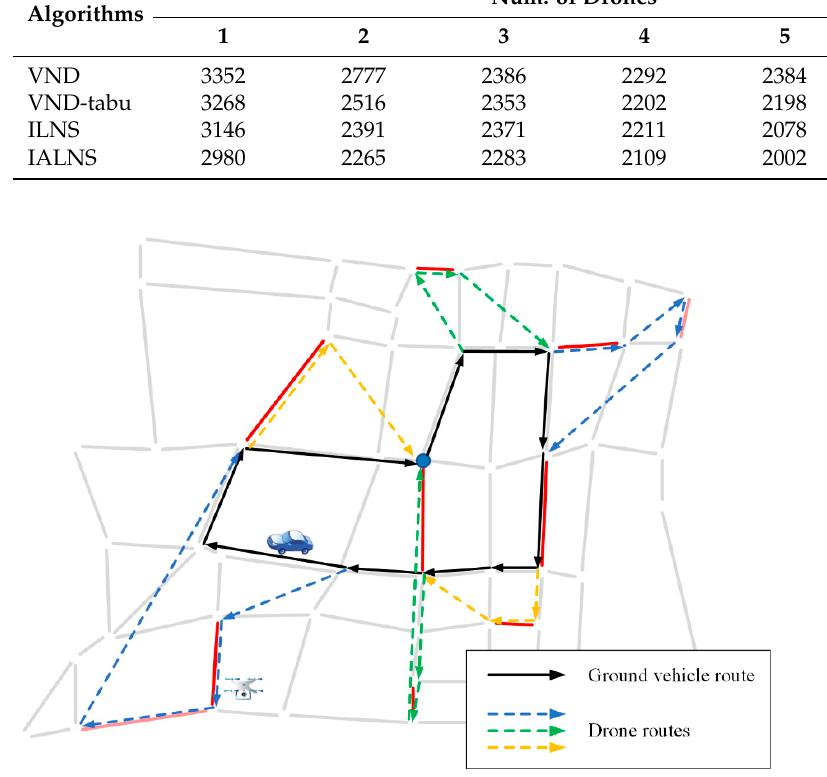
Figure 17. Route planning of the vehicle and the drones.